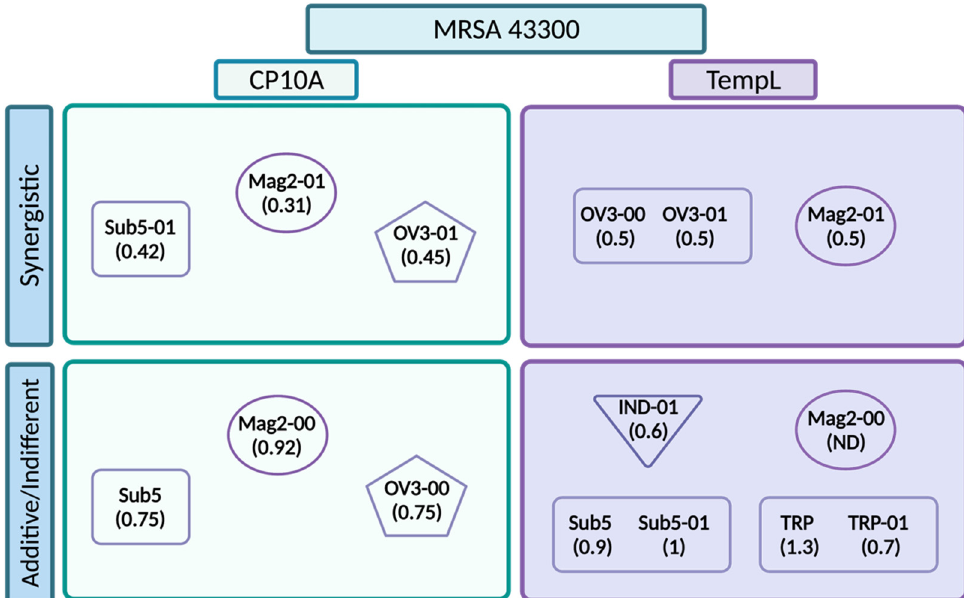
Figure 7. Summary of peptide interactions in MRSA 43300 from data presented in Results and Supplemental Material. Synergistic (or non-synergistic) interactions for CP10A and TempL with other peptides are grouped as shown. Parental and ATCUN derivatives are outlined in the same shape with the average FIC value shown in parentheses.